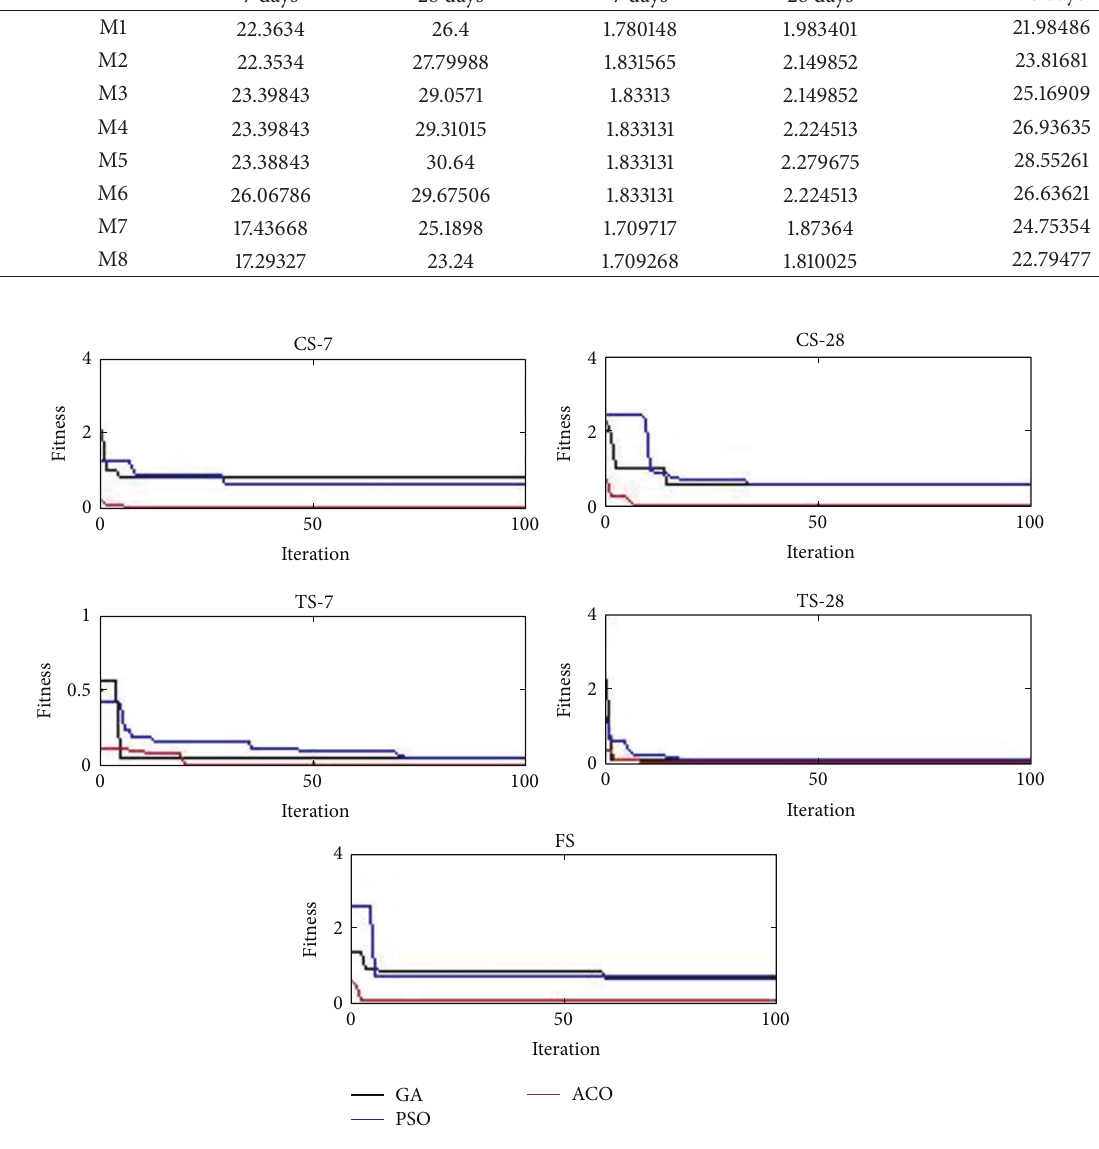
Figure 6: Convergence